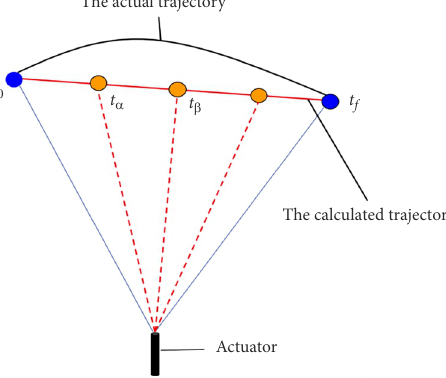
Figure 5. Schematic diagram of path